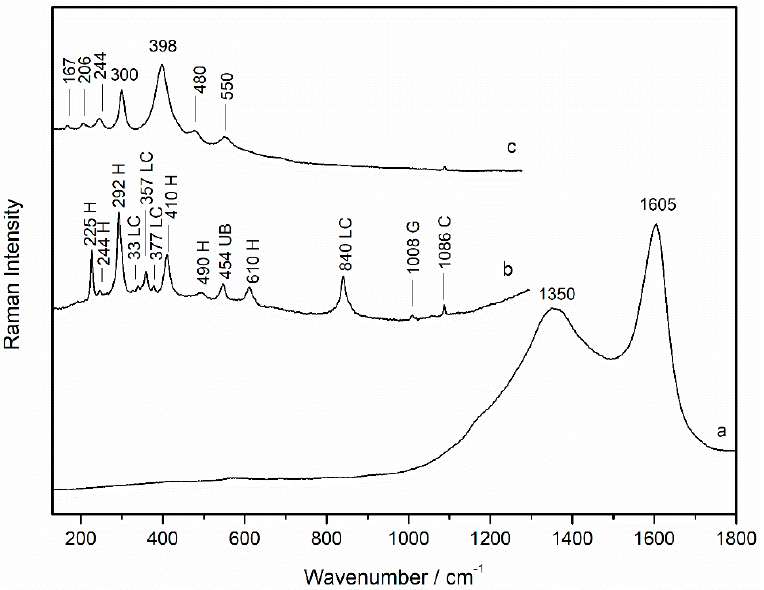
Figure 2. Raman spectra of ( a ) carbon black (532 nm excitation laser), ( b ) hematite together with the Raman bands of lead chromate (LC), ultramarine blue (UB), gypsum, and calcium carbonate, and ( c ) goethite (785 nm excitation laser) from a black area (sample wp2). According to Raman spectroscopy, the purple shade was obtained by a mixture of ultramarine blue (Al 6 Na 8 O 24 S 3 Si 6 , Raman bands at 258, 545, 584, 806, 1092, 1124, 1290, and 1642 cm − 1 , (Figure 3a) and the synthetic organic pigment alizarin lake (PR 83:1) (Raman bands at 484, 655, 901, 1190, 1292, 1325, 1354, and 1476 cm − 1 , (Figure 3b) [21,22]. The unex- pected presence of silicon (Si) detected in the black areas by micro-EDXRF would be ex- plained by the use of ultramarine blue, since a purple layer was found below in that area.